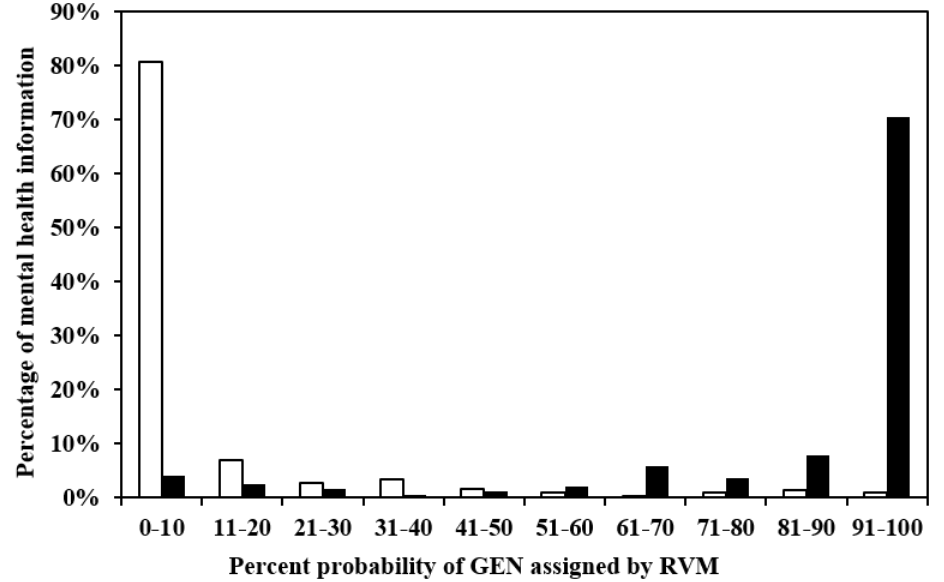
Figure 3. Percentage of generic (GEN) and patient-specific (PAS) mental health texts assigned to each 10% probability bin.